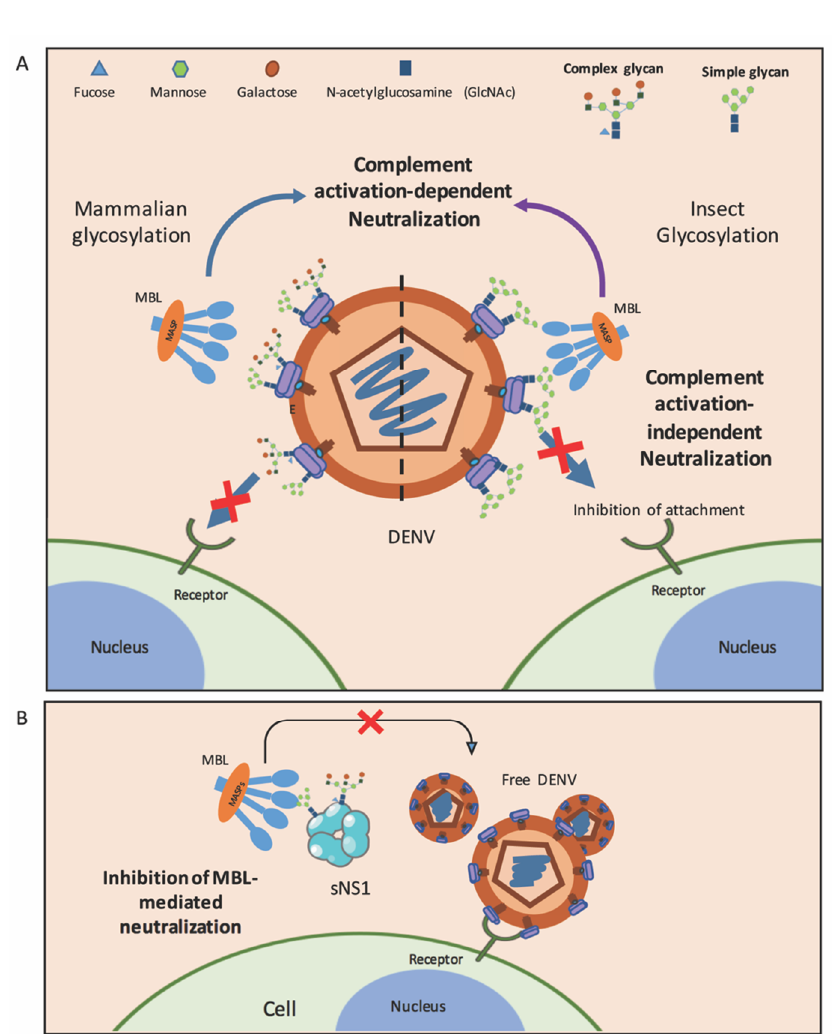
Figure 2. Roles of MBL in dengue. ( A ) MBL molecules inhibit DENV produced from mammalian cells (left) and insect cells (right) via complement activation-dependent or complement activation-independent pathways. Oligosaccharides on the E protein of DENV generated in mammalian cells are complex sugar and high-mannose, while those on the membranes of insect cell-derived viruses are only mannose. ( B ) DENV utilizes sNS1 to counteract MBL in order to escape MBL-mediated neutralization. Free DENV is able to bind to its receptor and infect target cells. Of interest, high-mannose residues attached to the E protein on the viral surface bind Table 1. Comparison of MBL-mediated neutralization between DENV and WNV. to dendritic cell-specific ICAM-3 by grabbing nonreceptor integrin (DC-SIGN; CD209)